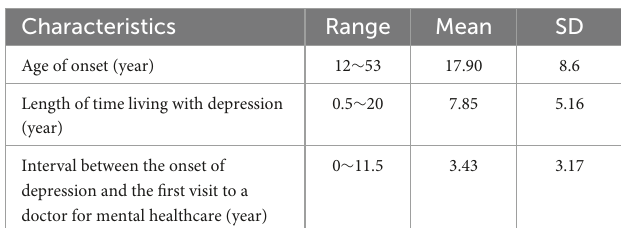
TABLE 1 Characteristics of the participants’ history of depression ( N =